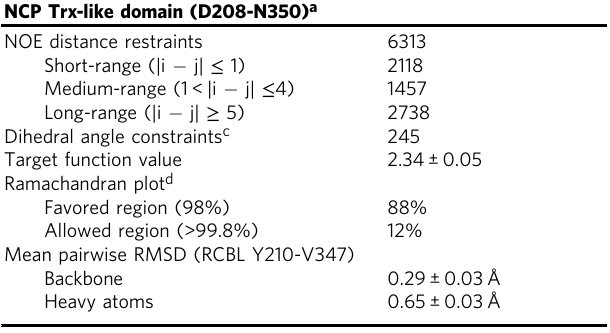
Table 1 Structural statistics for the Trx-like domain of